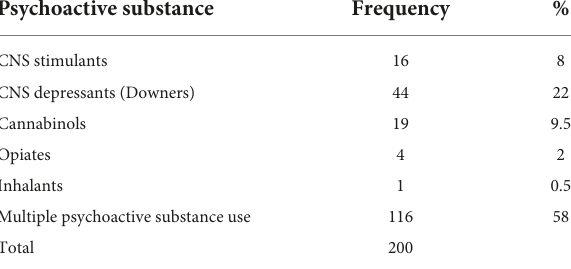
TABLE 2 Distribution of types of substance use among female psychiatric outpatients.